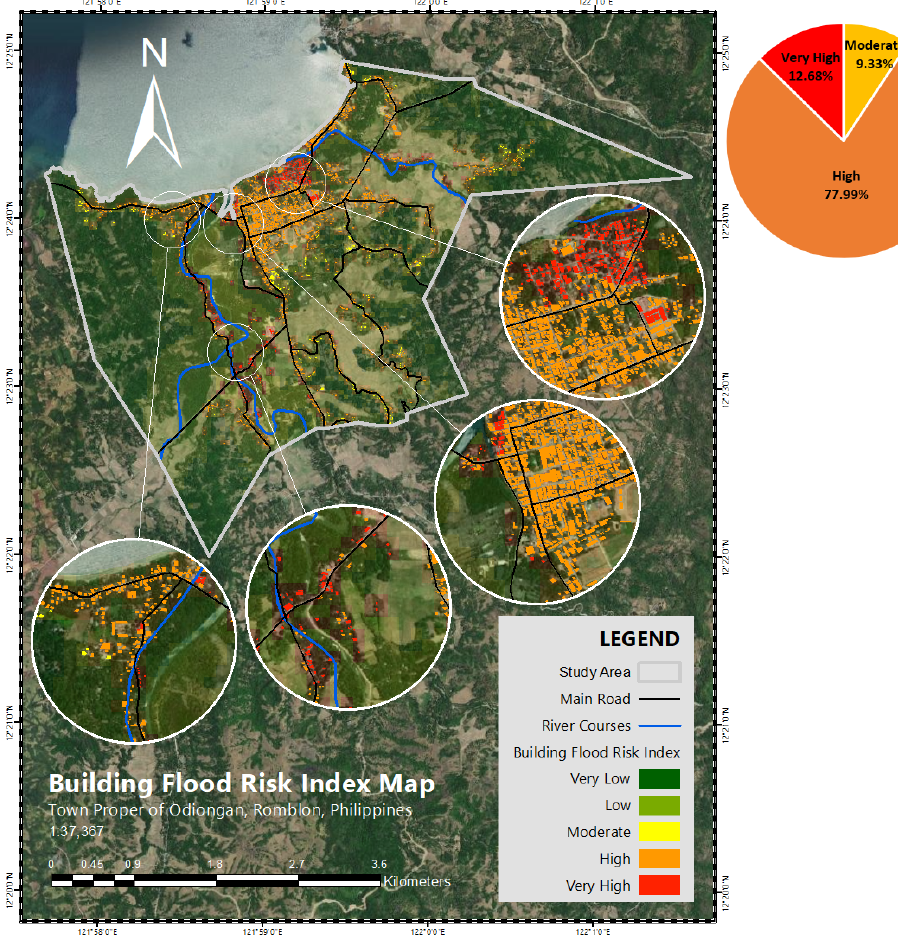
Figure 8. Building flood risk map with imagery and 1:15,000 scale zoomed-in map of concentrated areas with moderate to high risk of the town proper of Odiongan, Romblon.